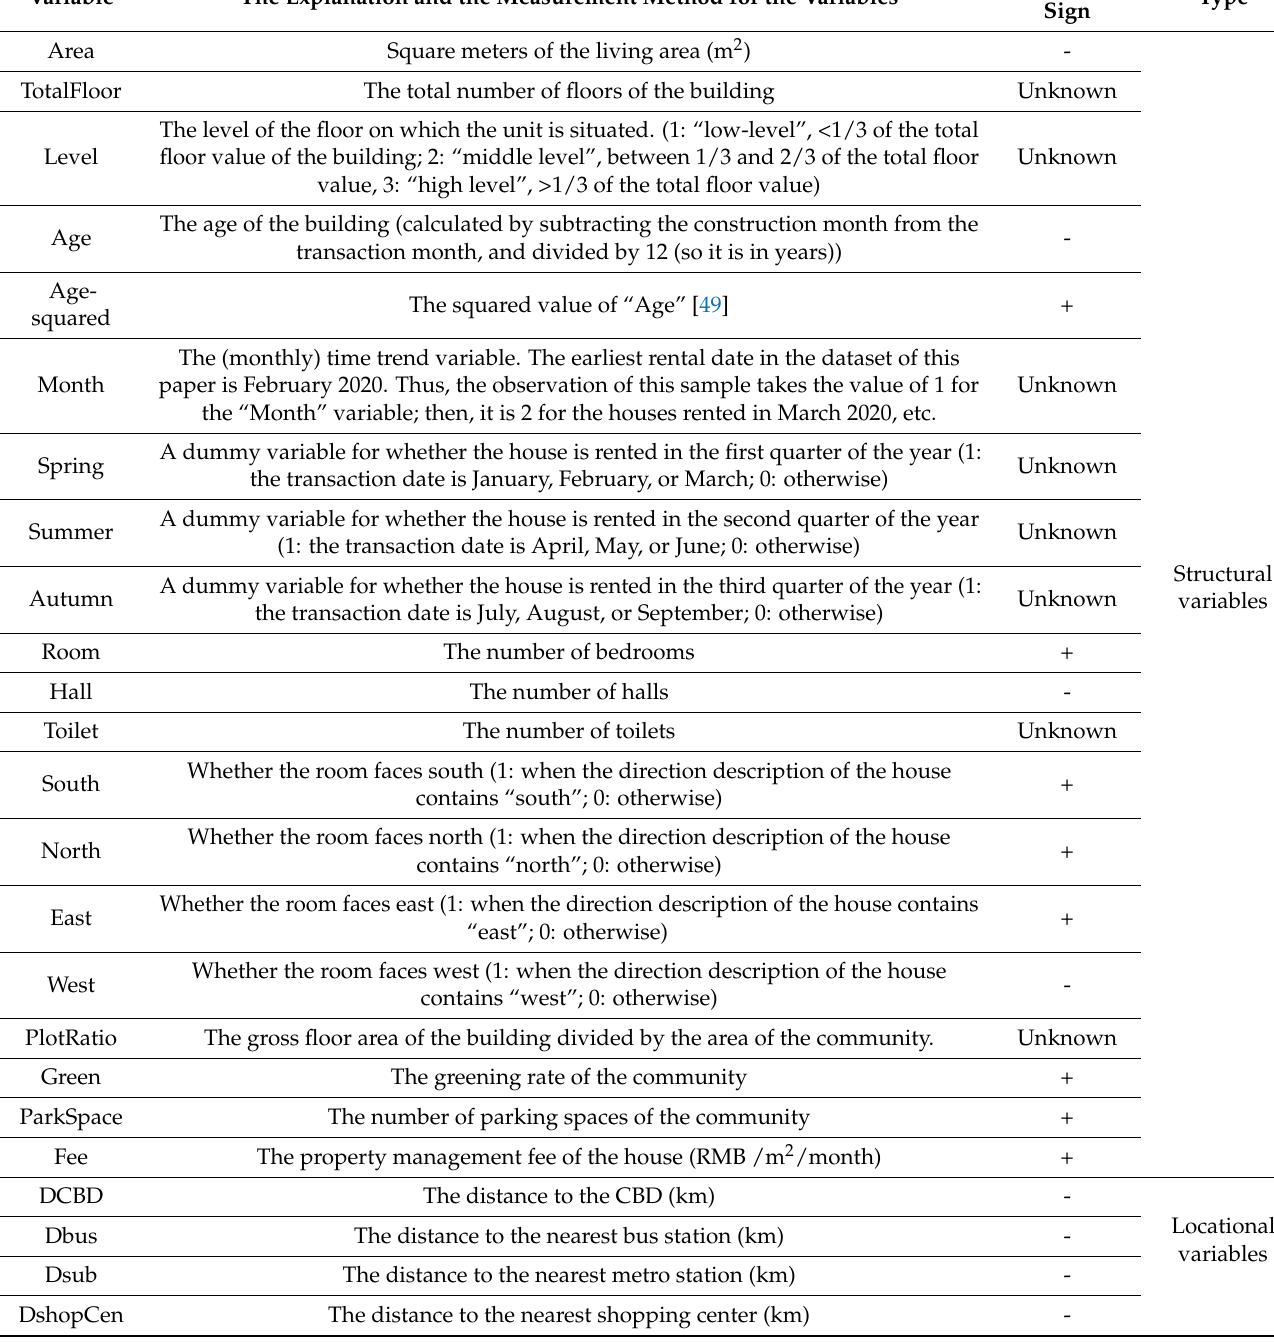
Table 2. The description of the rental house price and relevant